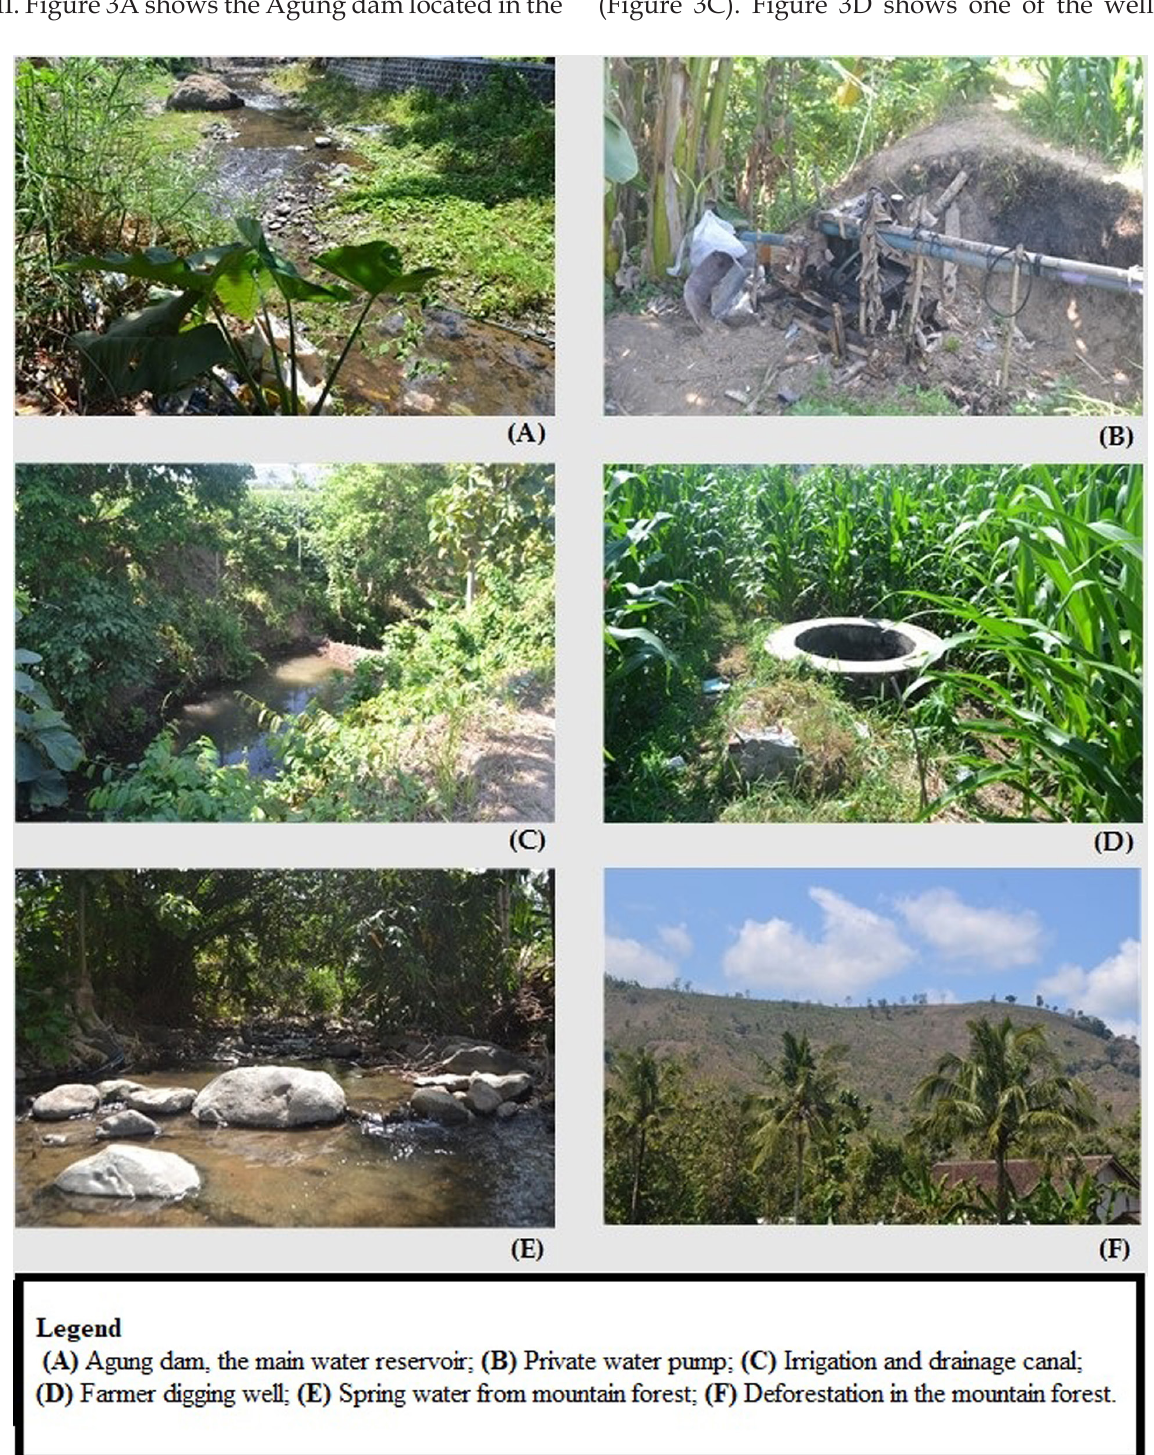
Fig. 3. Irrigation system in the studied